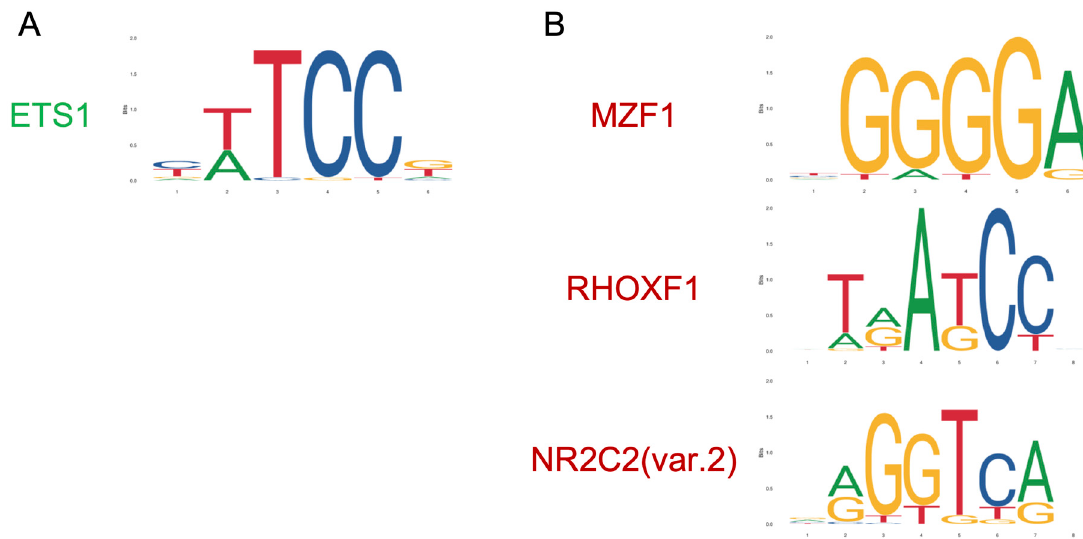
Figure 6. Transcription factors predicted to control the expression of lncRNA in response to olaparib. Transcription factors with potential binding sites in the promoter region ( − 1000 bp to +100 bp from the transcription start site) of ( A ) olaparib-upregulated lncRNAs and ( B ) olaparib-downregulated lncRNAs, as predicted by JASPAR.